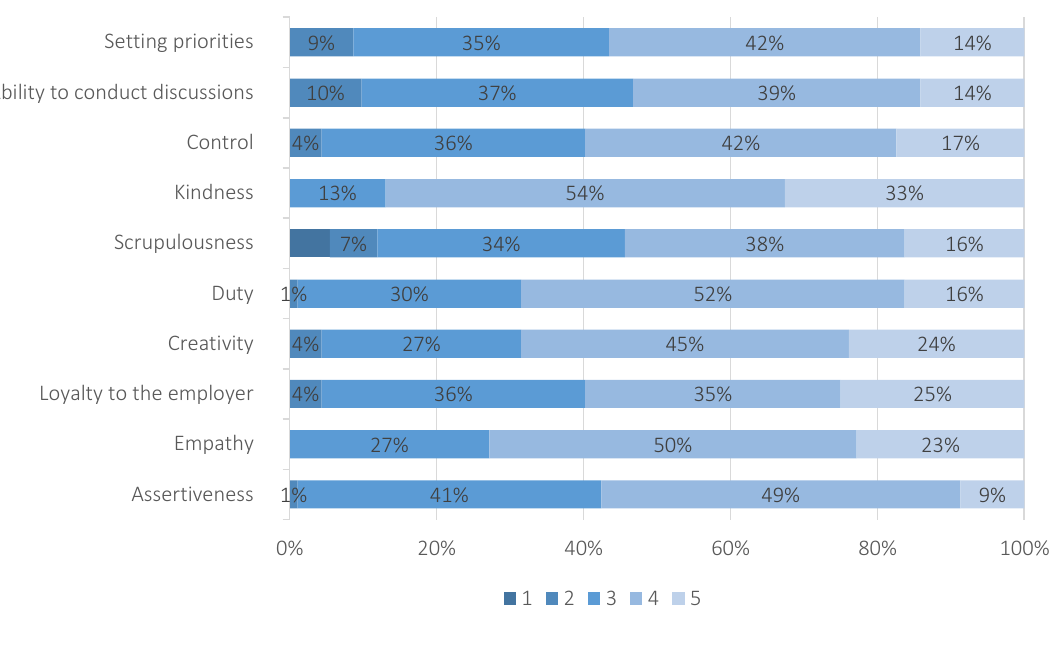
Figure 3. The level of personality traits of the enterprise team Table 5. The indication of the desired sector competencies to overcome the crisis Kind of